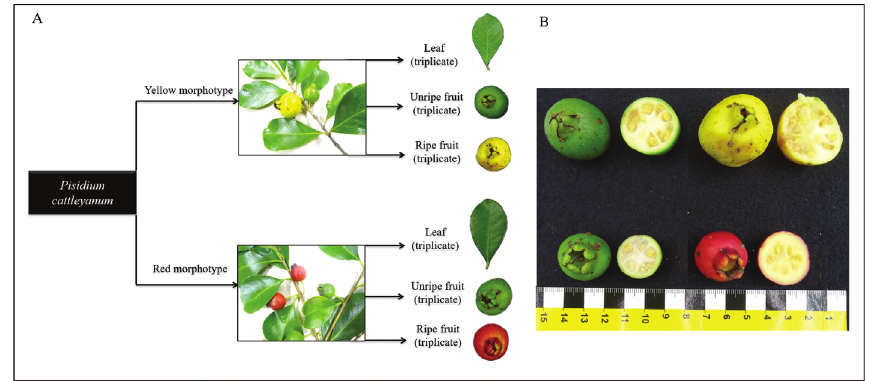
Figure 2 - RNA library scheme for transcriptome sequencing of the leaf and fruit tissues of the yellow and red morphotypes (A). Epicarp and endocarp characteristics of the yellow and red morphotypes of P. cattleyanum